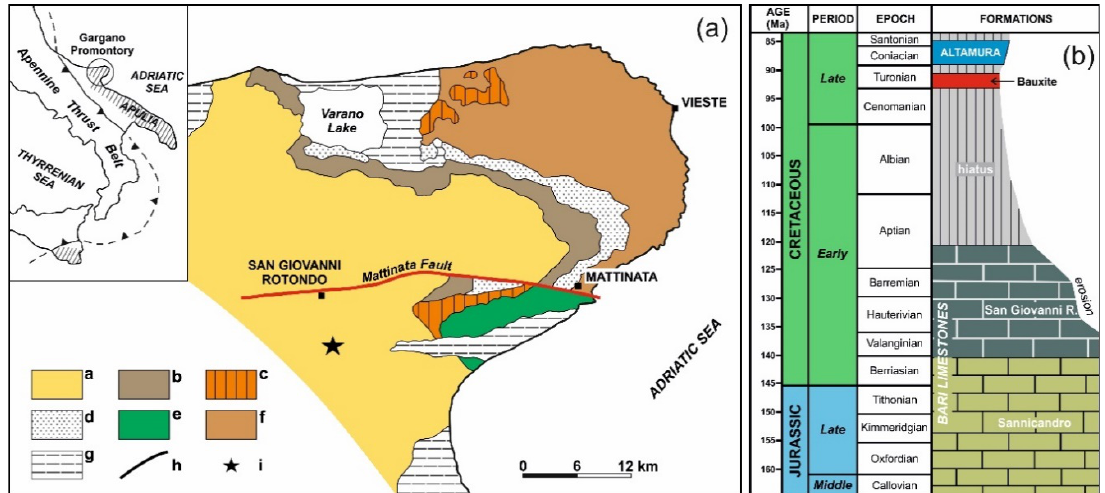
Figure 2. ( a ) Geological map showing the Cretaceous units that outcrop the Gargano Promontory. a:shallow-water facies associations (Malm–Cenomanian), b: marginal facies associations (Malm– Lower Cretaceous), c: slope and related marginal facies associations (Cenomanian), d: slope facies associations (Tithonian–Albian); e: slope facies associations (Turonian–Senonian), f: basinal facies associations (Berriasian–Senonian p.p.), g: continental clastics (Quaternary), h: Mattinata transcurrent fault, and i: sampled bauxite. ( b ) A representative stratigraphic column (modified from